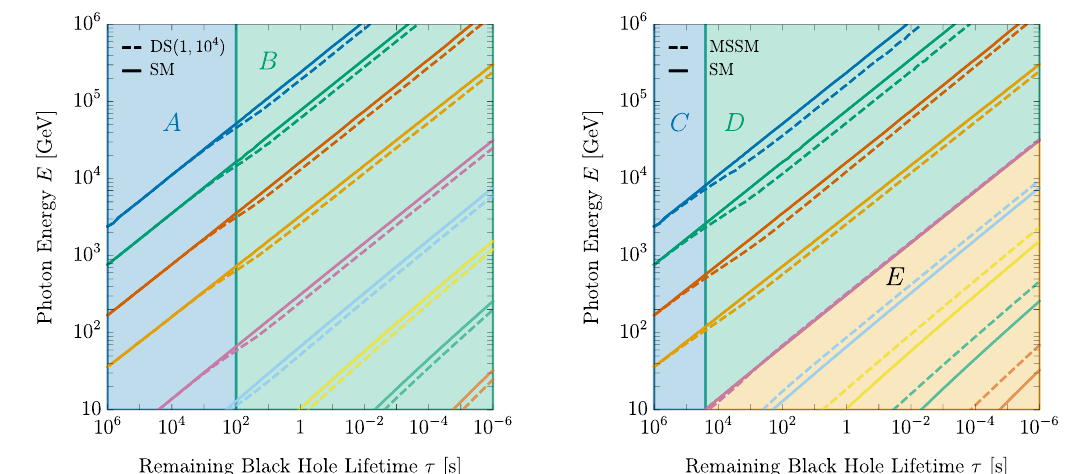
Figure 9 . Possible binning regions for models with new particles which only interact weakly with photons (left), in this case the DS (1 , 10 4 ) benchmark with the same contours as figure 7 (left), and models which produce a significant number of secondary photons (right), in this case our MSSM